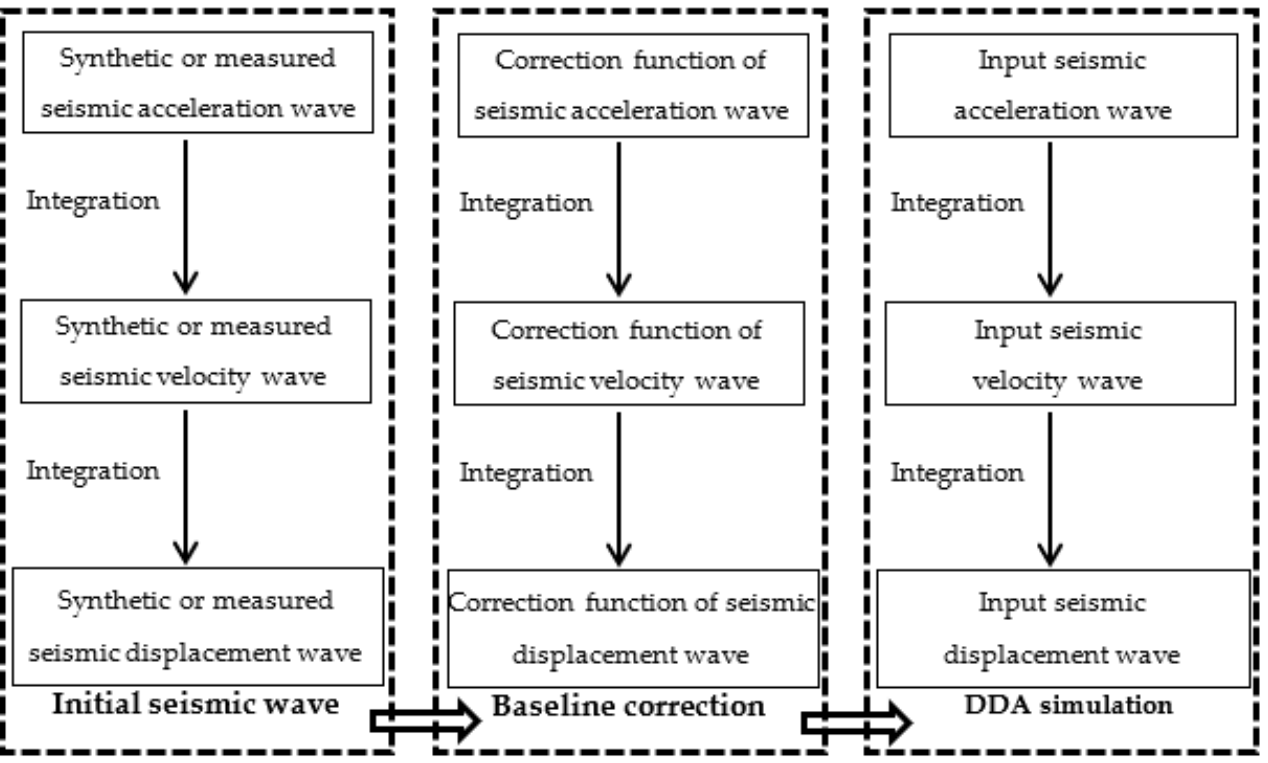
Figure 2. Processing of seismic wave data in DDA simulation.